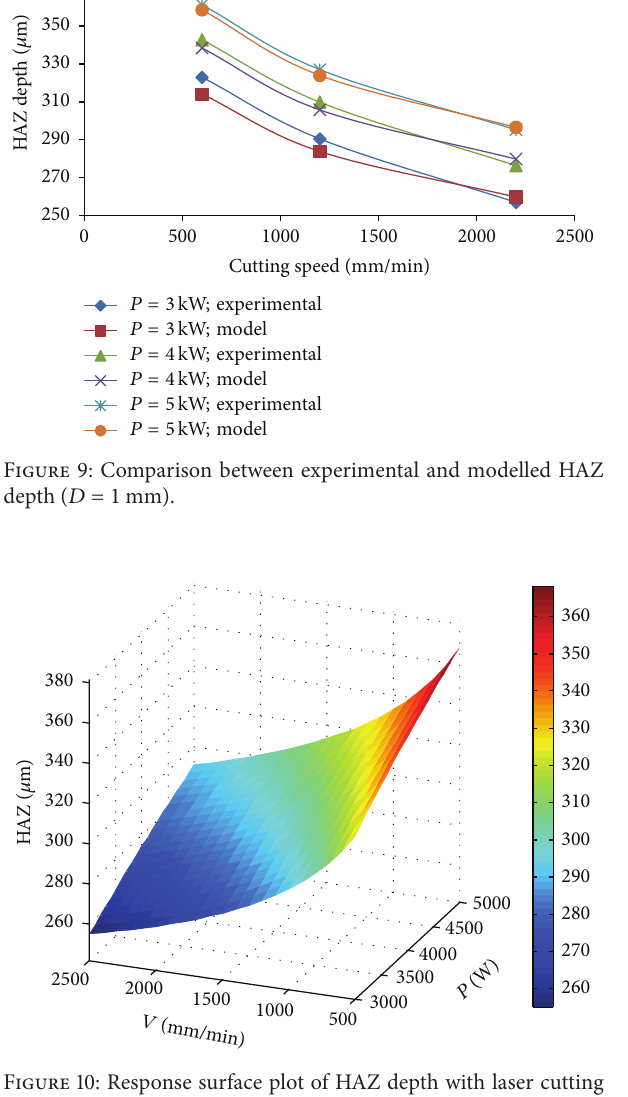
Figure 10: Response surface plot of HAZ depth with laser cutting speed and laser power ( 𝐷 = 1 mm).